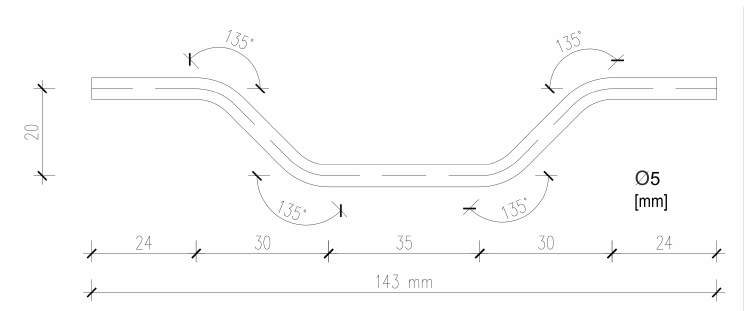
Figure 6. Detail of the reinforcement